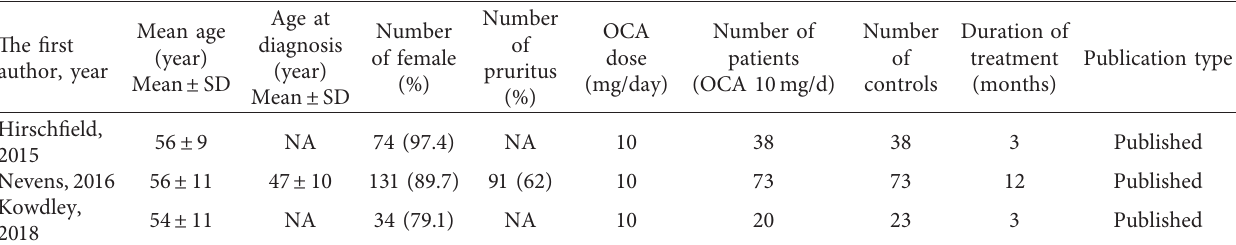
Figure 3: Risk of bias graph in the included studies: authors’ judgments for each risk of bias item presented as percentages. Table 1: Baseline characteristics of the included studies.